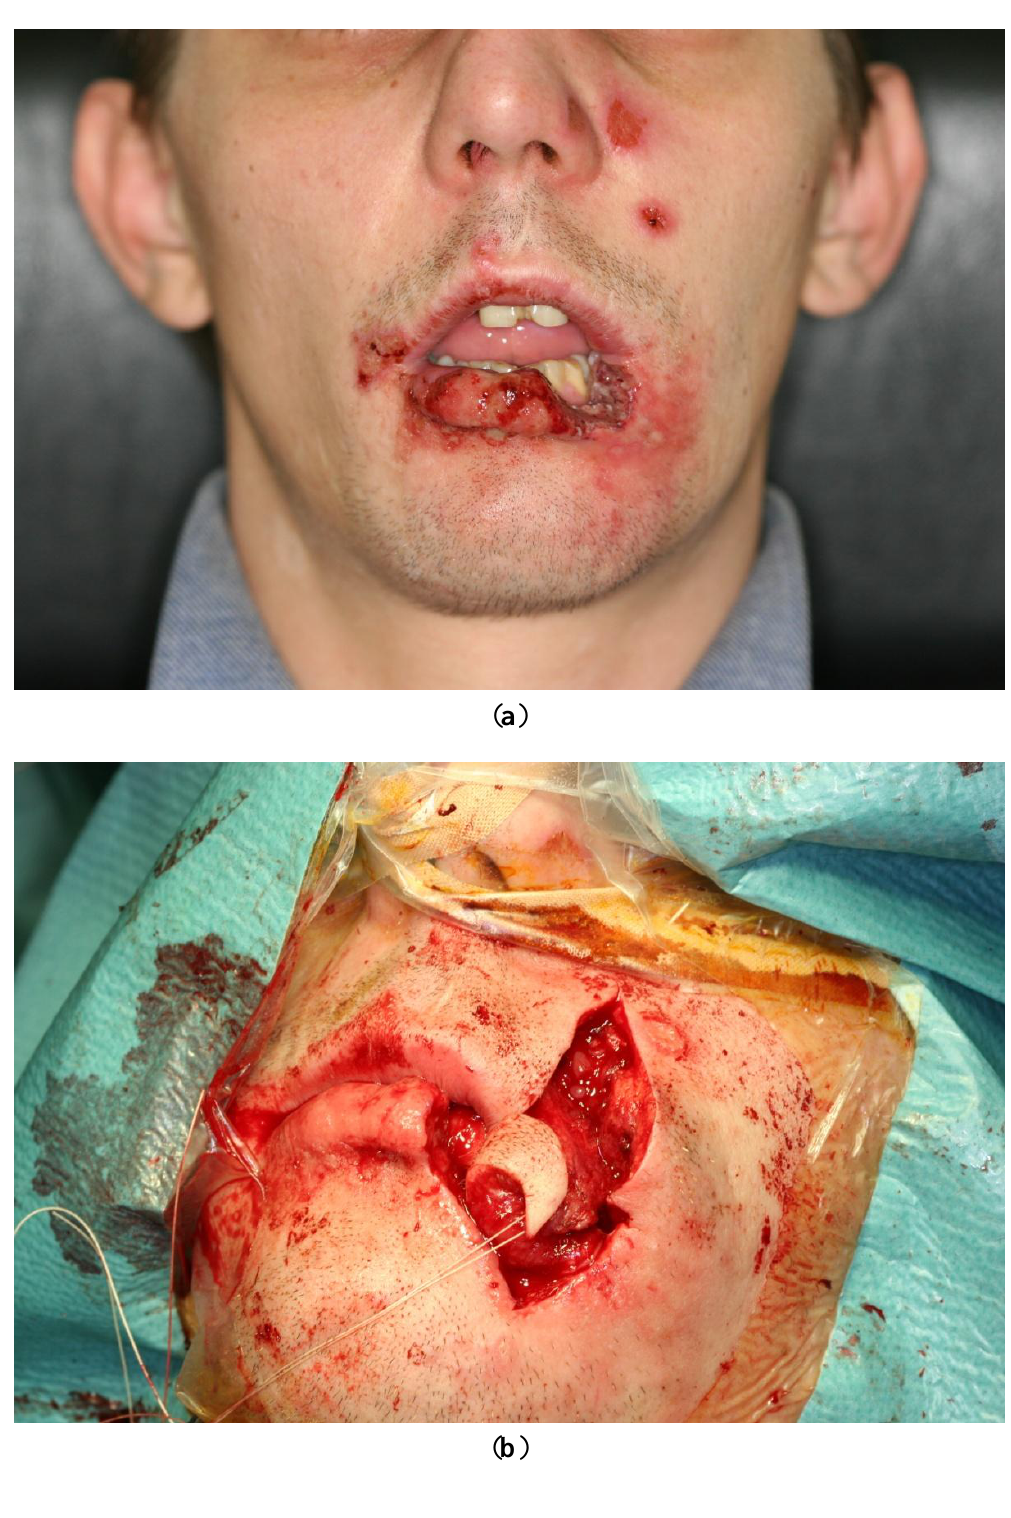
Figure 5. Plastic reconstruction after traumatic tissue loss in the lateral lower lip with sufficient reconstruction of the corner of the mouth (Operation performed by Dr. Marcus